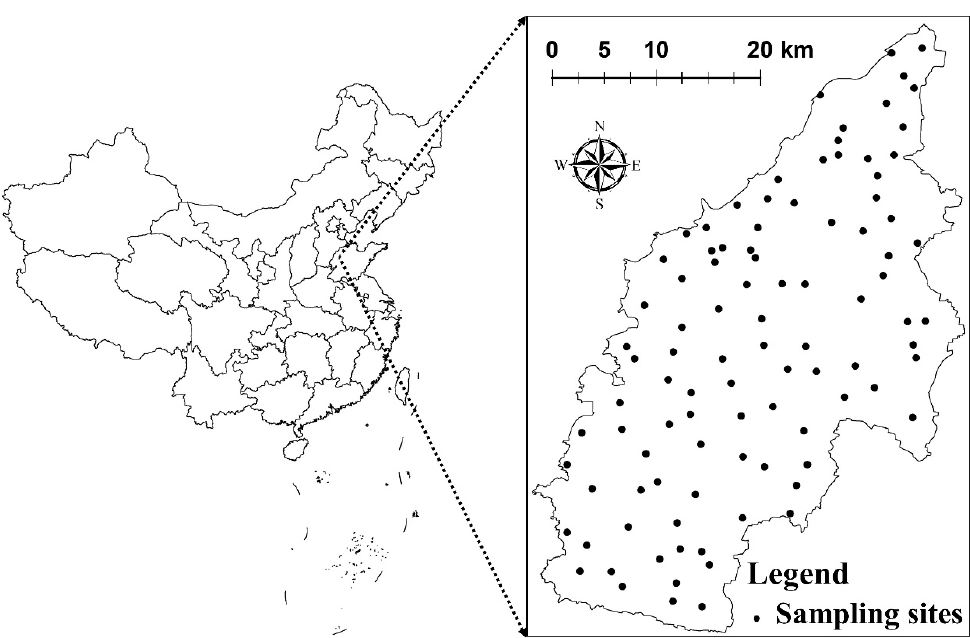
Figure 1. Study area and the sampling sites in Yucheng County, Shandong Province, China.